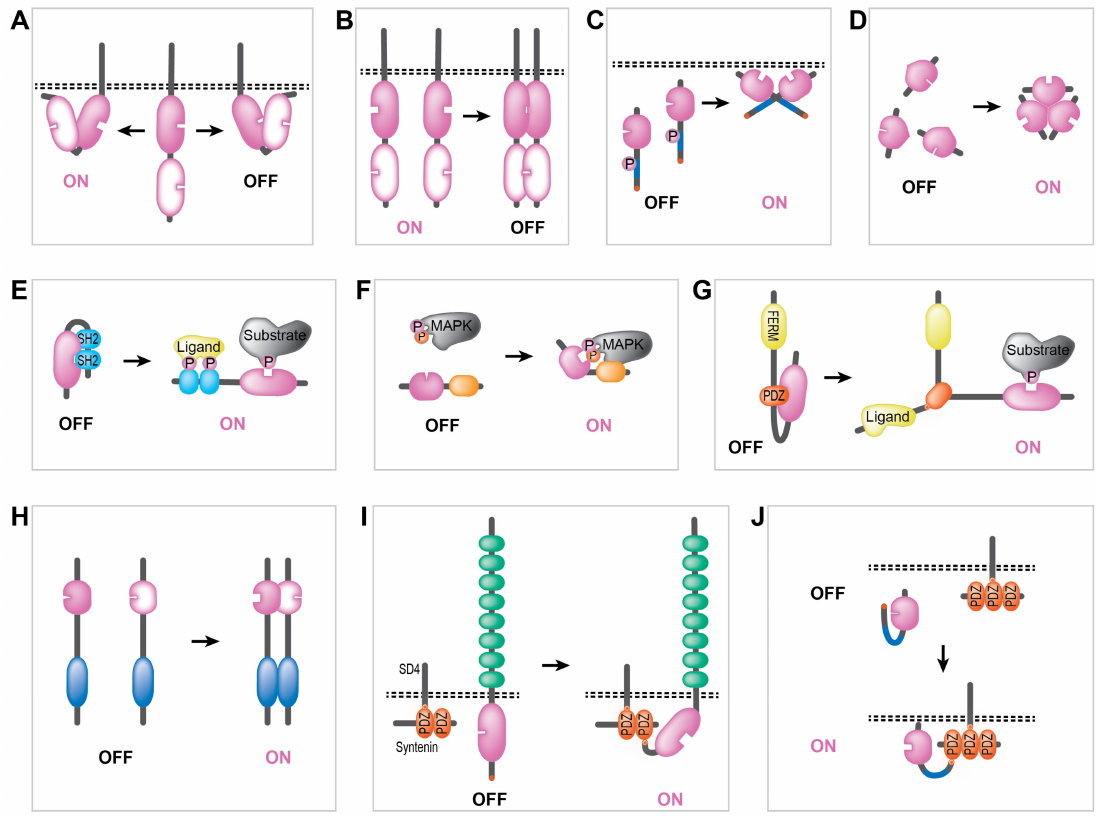
Figure 2. Protein interaction-dependent regulatory mechanisms impinging on PTPs. ( A ) Intramolecular interactions between membrane-proximal and -distal PTP domains may boost or attenuate enzymatic activity. ( B ) Dimerization of RPTPs usually inhibits enzyme activity. ( C ) Active PTEN homodimers form once the C-terminal part is dephosphorylated. ( D ) PRLs trimer formation enables enzyme activity. ( E ) SH2-containing PTPs are activated by phosphotyrosine-containing ligands. ( F ) Interactions between the CDC25-like domain in MAP kinase phosphatases and the substrate MAPK boost PTP activity. ( G ) PDZ target sequences, upon binding to PDZ domains in PTPs, trigger enzymatic activity of the latter. ( H ) Heterodimerization with inactive members of the MTMR subfamily boosts the enzymatic function of active subfamily members. ( I ) Submembranous PDZ domains trigger enzymatic activity upon binding to PDZ target sequences in RPTPs. ( J ) Submembranous complexes with PDZ-containing proteins are able to recruit the activity of PDZ target sequence-containing PTPs. For more details on these types of regulation and the associated references we refer to the